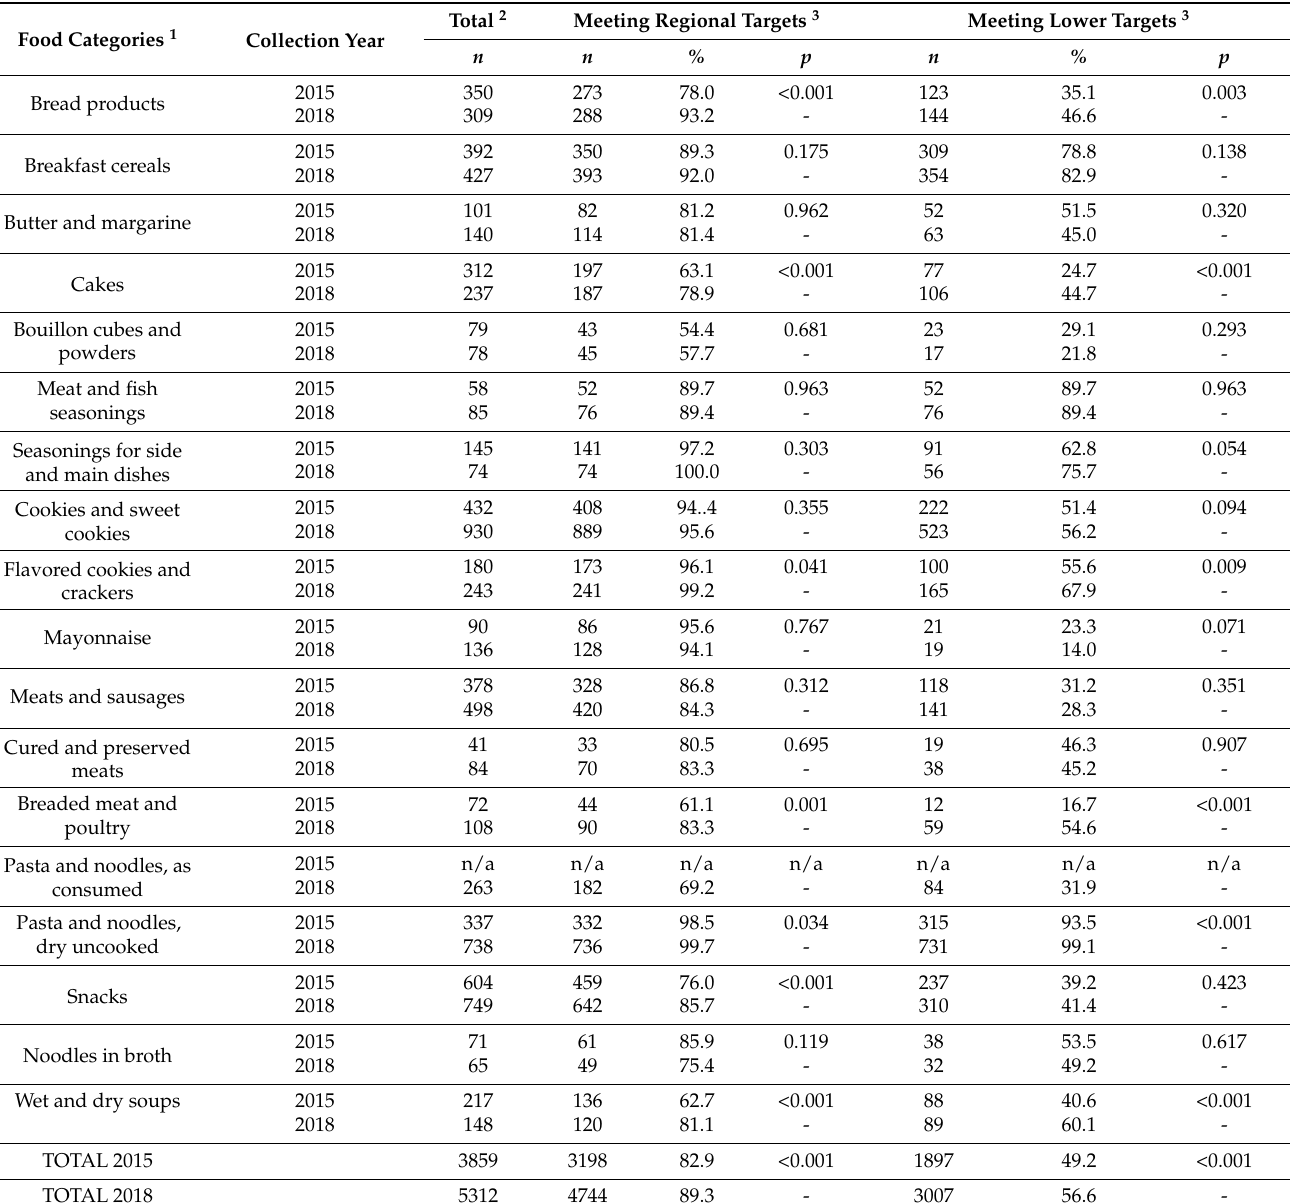
Table 1. Changes in the proportion of foods meeting the regional and lower targets in Argentina, Costa Rica, Paraguay, and